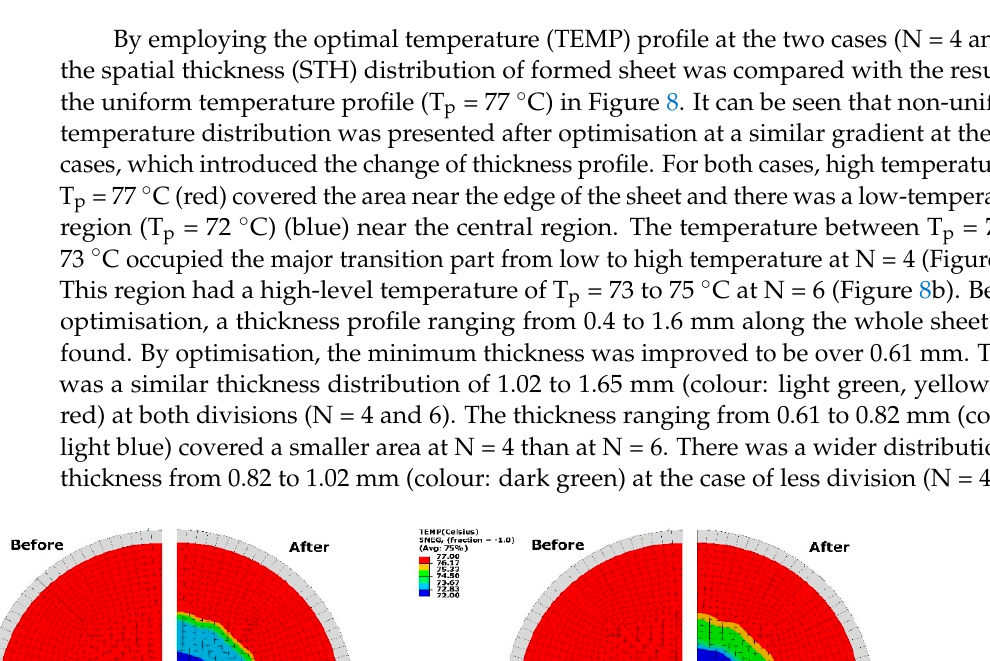
Figure 8. Temperature (TEMP, top) and thickness (STH, bottom) before and after optimisation. ( a ) N = 4 , ( b ) N = 6. In Figure 9, the thickness distribution along the radius from centre to edge illustrated a big increase from 0.5 to 0.7 mm by 40% within R = 50 mm after optimisation. A small decrease of thickness of 0.1 mm was observed from optimisation beyond R = 50 mm. The overall thickness ranged from 0.7 to 1.6 mm after optimisation. Between the distance of R = 30 to 50 mm, a smoother transition of thickness was exhibited at uniform temperature profile than the results at non-uniform cases. A step change of thickness was more evi- dently found at the optimised temperature at N = 4, indicating a sharp increase and de- crease at distance from R = 30 to 60 mm. This tendency was weakened at N = 6 by intro- ducing a small temperature gradient with more divisions. Figure 9. Thickness distribution at different processing conditions. The results of nominal strain in Figure 10a displayed a big decrease of hoop strain ( ε 11 ) at the radius of R = 30 mm from ε 11 = 1.1 to 0.6 by an approximate decrease of 45%. The degree of decrease of hoop strain beyond R = 30 mm reduced gradually and disap- peared after R = 72 mm. Figure 10b showed a decrease of axial strain ( ε 22 ) by optimisation from ε 22 = 1.3 to 0.7 within a radius of R = 30 mm. No monotonic change of axial strain ( ε 22 ) at uniform temperature profile was observed compared to the result from optimisation. At N = 4, the decease of axial strain by optimisation continued until the radius of R = 48 mm and the elevation of axial strain occurred. This tendency showed some differences for the optimisation result at N = 6, indicating a dramatic decrease of axial strain and subse- quent increase until R = 38 mm, after which the axial strain from optimisation exceeded the result at uniform temperature. Beyond R = 82 mm, there was a small difference of the